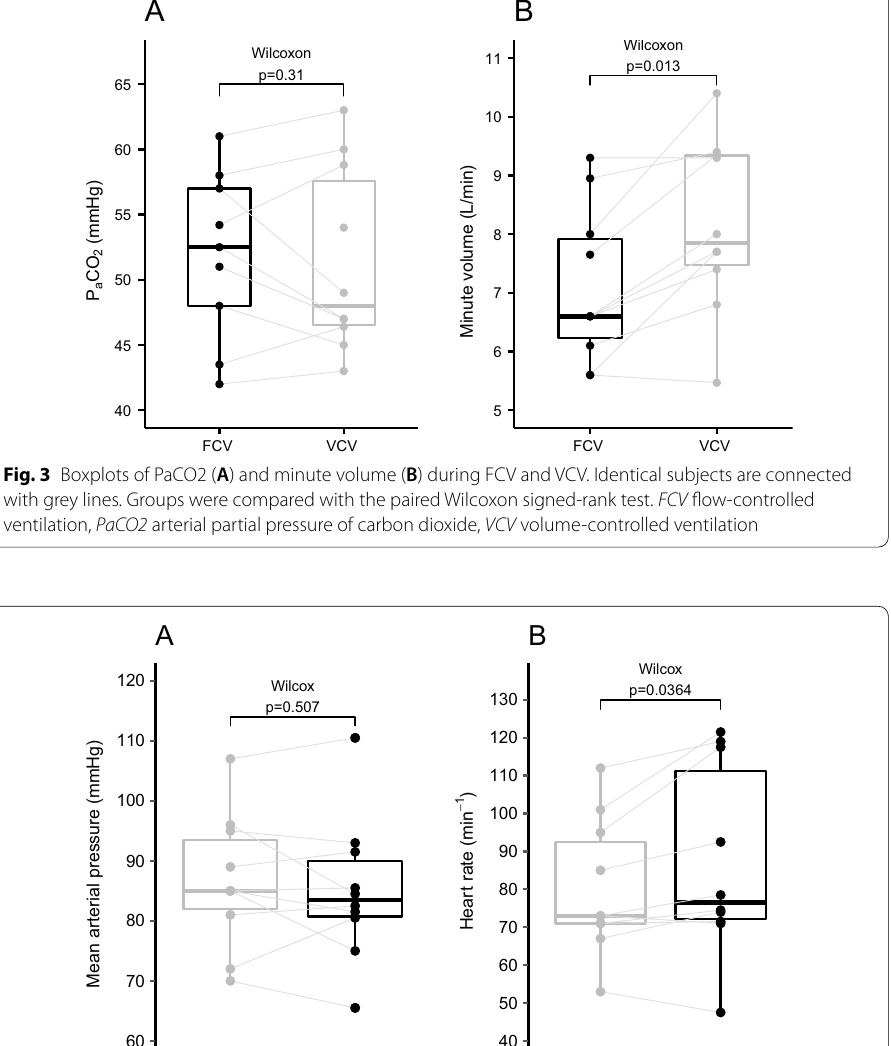
Fig. 4 Boxplots of mean arterial pressure ( A ) and heart rate ( B ) during baseline PCV and FCV. Identical subjects are connected with grey lines. Groups were compared with the paired Wilcoxon signed-rank test. FCV flow-controlled ventilation, PCV pressure-controlled